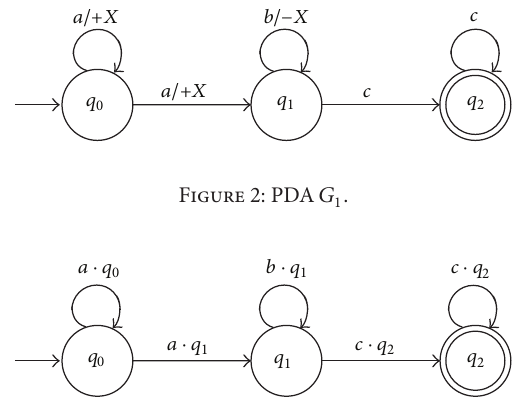
Figure 3: Finite-state overapproximation 𝐺 1 of 𝐺 1 .